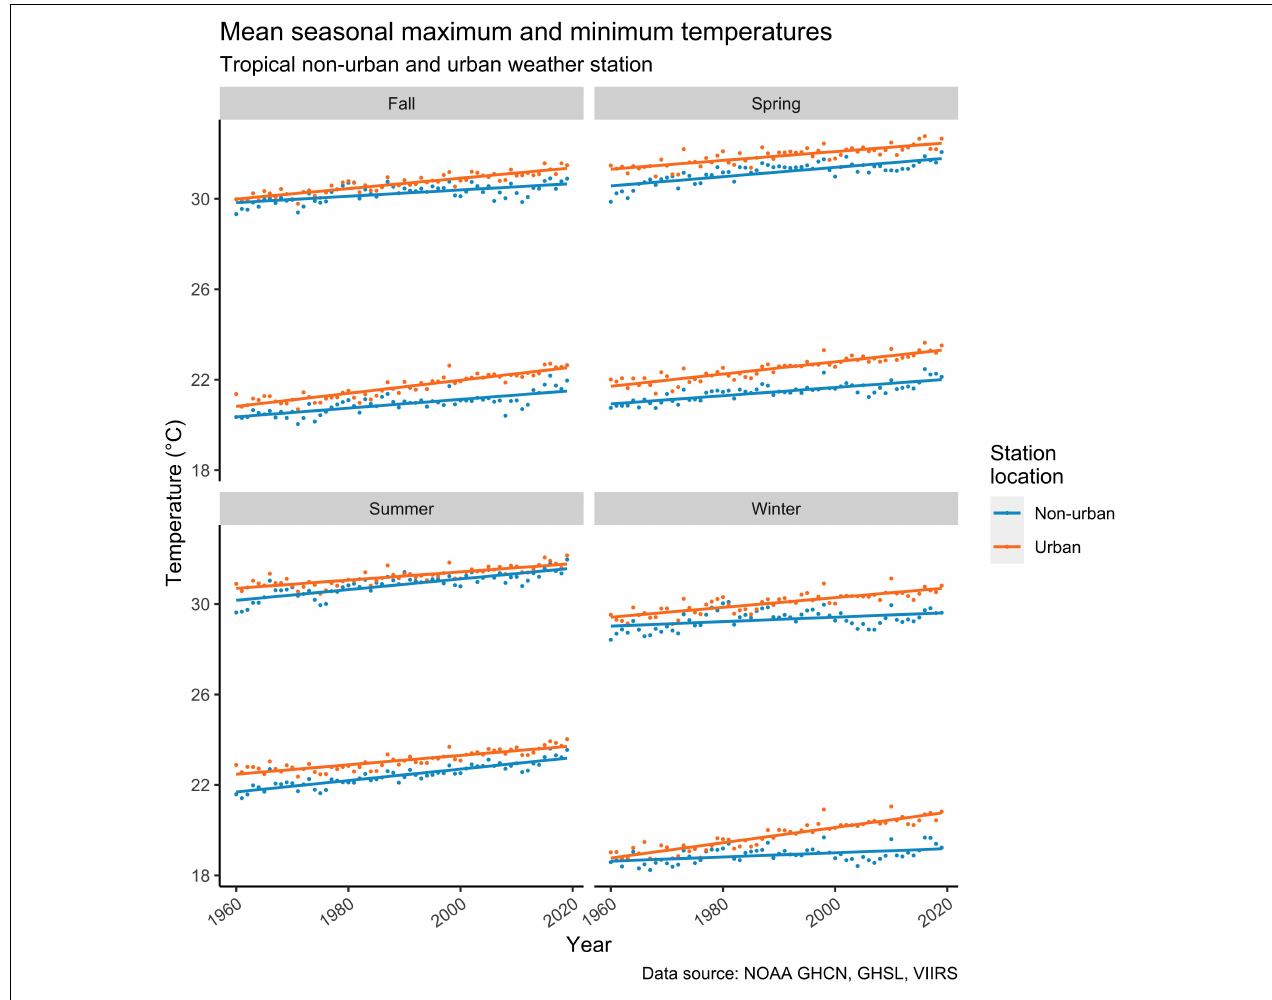
FIGURE 9 | Mean seasonal maximum and minimum temperatures for urban and non-urban areas. The higher points and curves on each mini-plot represent the maximum temperatures and the lower points and curves represent the minimum temperatures. Data source: NOAA, GHCN.